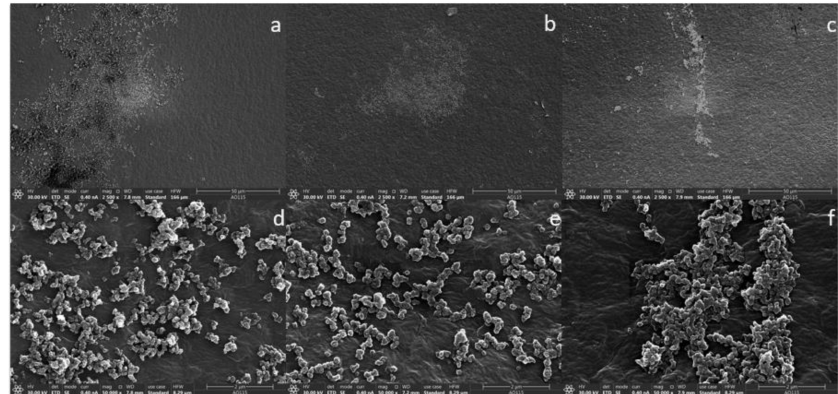
Figure 5. SEM micrographs of Arthrobacter sp. attached to the polyethylene film surface. Unpretreated plastic film (UPF) at 2500 × magnification ( a ) and 20,000 × magnification ( d ). Weathered plastic film (WPF) at 2500 × magnification ( b ) and 20,000 × magnification ( e ). Buried plastic film (BPF) at 2500 × magnification ( c ) and 20,000 × magnification ( f ).